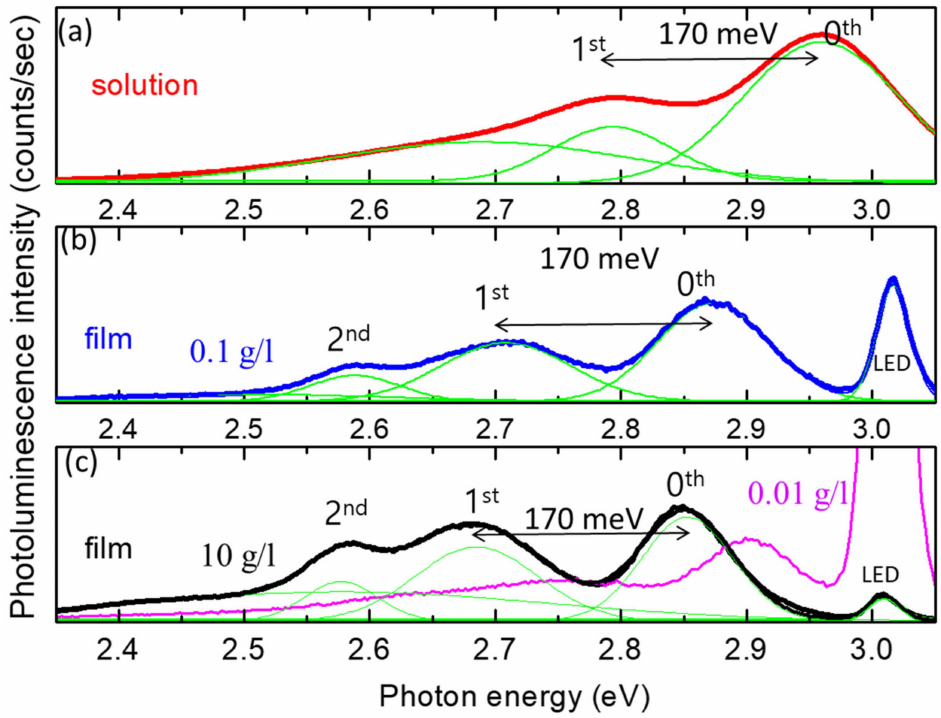
Figure 3. PL spectra of PEE with toluene solvent. The spectra were divided by spectrometer sensitivity. In the spectra, the main PL peak (labeled 0th) corresponds to the bandgap energy and the PL peaks (labeled lst and 2nd) are attributed to the phonon side-band peaks. Green curves show the peak deconvolution results with Gaussian functions. ( a ) Solution phase of PEE in a concentration of 0.1 g/L. ( b ) PEE film fabricated with a concentration of 0.1 g/L. ( c ) PEE films fabricated with concentrations of 10 g/L (black) and 0.01 g/L